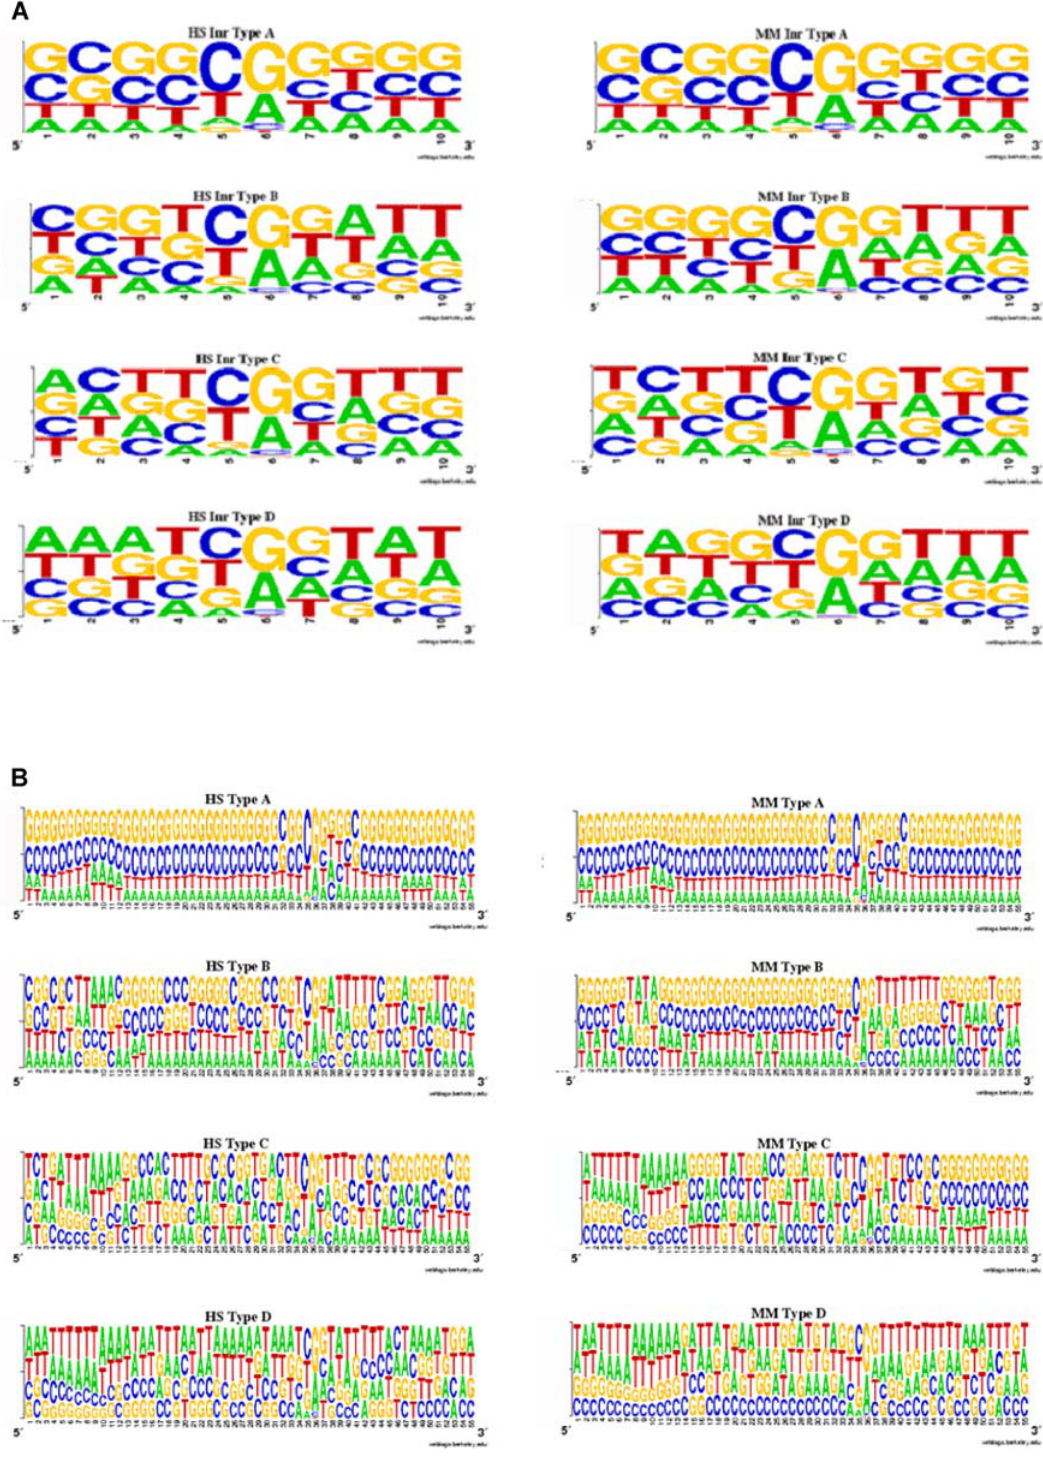
Figure 5. Sequence Logos (A) Sequence logos for Inr in human (left) and mouse (right) obtained using [ (cid:2) 5, þ 5] segments relative to TSS locations. There is an evident bias in the nucleotide composition surrounding the TSS that effectively determines different Inr elements. (B) Sequence logos for segments [ (cid:2) 35, þ 20] relative to TSS locations. Strong similarity exists between human (left) and mouse (right) in TSS type A, while that similarity is considerably reduced for the other TSS